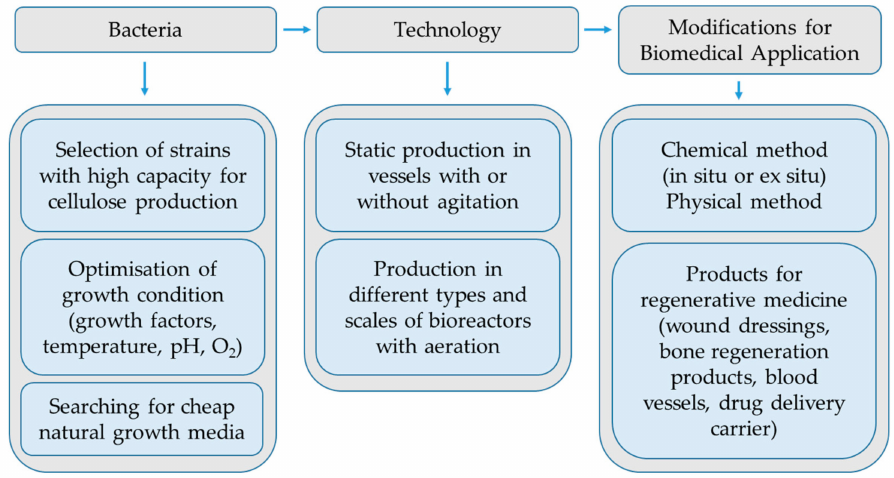
Figure 1. Scheme presenting the most important aspects which have to be considered for bacterial cellulose (BC)-production with biomedical